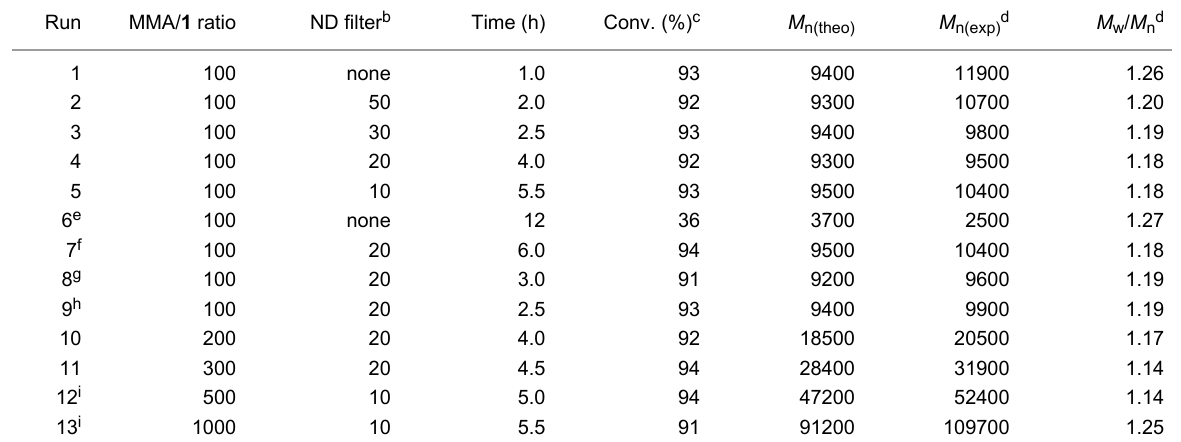
Table 1: Photopolymerization of MMA in the presence of 1 under LED irradiation. a